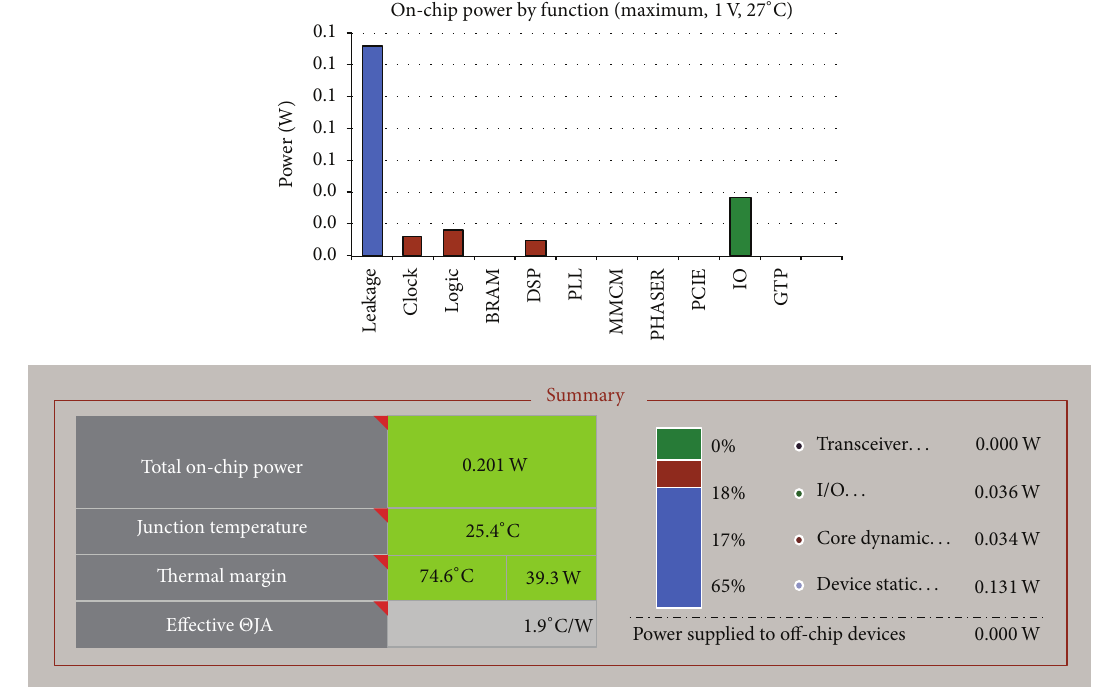
Figure 4: On-chip power utilization of 3D-integer DCT for the integer set [ 10, 9, 6, 2, 3, 1, 1 ] .